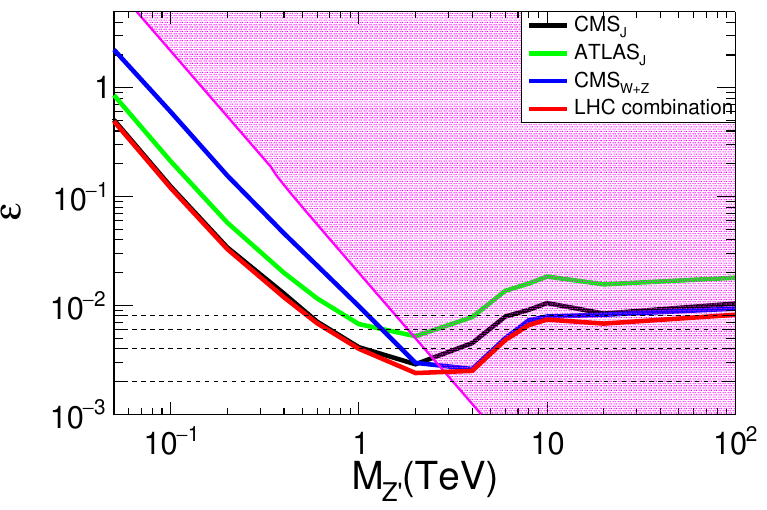
Figure 9. Projection of exclusion limit on NSIs for LHC with an integrated luminosity of 300 fb − 1 , in a simplified Z 0 model as a function of the mass of Z 0 . We assume (cid:15) u = (cid:15) d = (cid:15) and Γ Z 0 /M Z 0 = 0 . 1 , and use the NLO predictions with theoretical